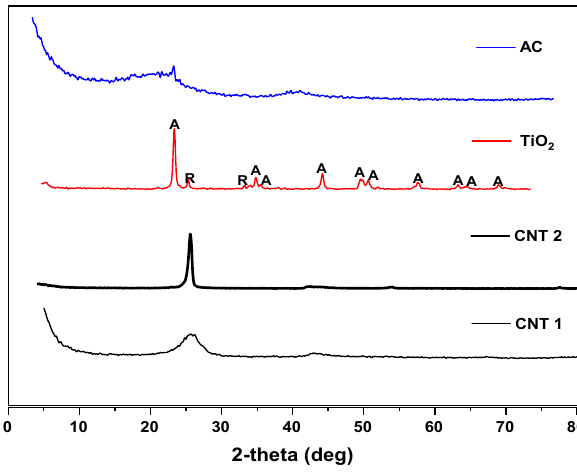
Figure 1: XRD patterns of CNT2, TiO 2 , CNT1, and